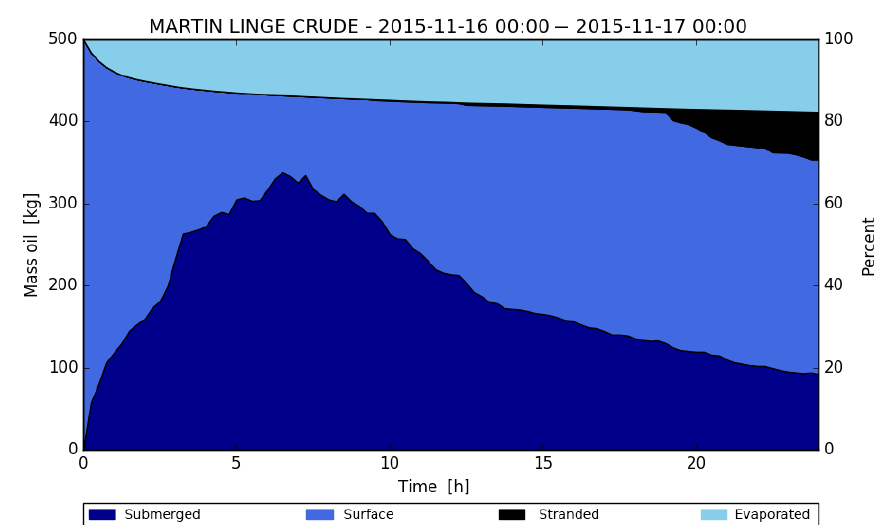
Figure 4. Plot of the time evolution of the oil budget of a 24h simulation with OpenOil. Of 500kg oil initially at the ocean surface, about 20% is seen to evaporate within the 24h. The amount of oil submerged due to wave action and ocean turbulence varies with the wind and wave conditions, with more oil resurfacing when wind decreases after about 7h. After about 18h, some of the oil is seen to hit the coastline. These results are for the oil type “Martin Linge crude”; very different results could be obtained if using another oil type for the same geophysical conditions.